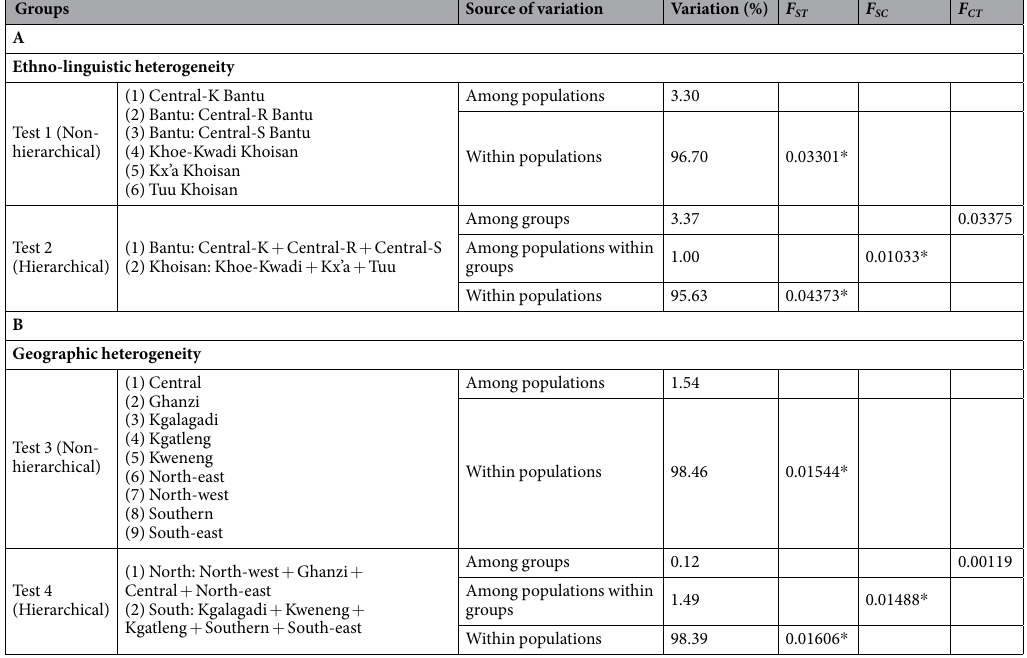
Non-hierarchical AMOVA testing for ethno-linguistic and geographical variation showed greater variation amongst self-declared ethno-linguistic groups than among the geographic groups at 3.30% and 1.54% respectively (Table 1 Test 1 and 3). Hierarchical AMOVA testing for ethno-linguistic variation between the self-declared Bantu and Khoisan ethno-linguistic population groups (n = 970) showed greater within population variation (95.63%) than among populations within groups (1.00%) (Table 1 Test 2). Hierarchical AMOVA testing for geographical variation between the northern and southern districts (n = 990) showed 0.12% variation amongst groups; and higher variation within populations at 98.39% than amongst populations within groups at 1.49% (Table 1 Test 4). Variation among populations within groups was higher when testing for geographic heterogeneity (1.49%) than for ethno-linguistic heterogeneity (1.00%). The relationship between Bantu and Khoisan self-declared sub-language ethno-linguistic groups is further illustrated using factorial correspondence analysis (FCA) (Fig. 2a) Bantu Central-S is an outlier. The Bantu Central-K and-R cluster together separated from the Khoisan sub-groups. This is a result of their common ori- gin (southwest Zambia) and subsequent gene flow as they settled in the same geographical region (Northwest district) 10 The FCA comparing the nine administrative districts illustrated in Fig. 2b shows the Ghanzi district is an outlier. The Northwest, Ghanzi, and Kgalagadi districts are slightly separated from the cluster formed by the remaining six administrative districts. This result illustrates both the close relationship of the Bantu Central-K and -R as well as the districts with Khoisan can be seen as outliers. F ST , AMOVA, and FCA show evidence of the greater influence of ethno-linguistics on population structure than geography. The partition of genetic variation within Botswana is due to ethno-linguistics which conse- quently influences the geographic distribution of genetic variation due to the geographic pattern of genetic distri- bution as evidenced by F ST , AMOVA and FCA data. The results of the model-based cluster analysis method in STRUCTURE are shown in Fig. 3, assuming K = 1–6 ancestral components. The Δ K method 52 identified three populations as having the highest level of genetic struc- turing. Three genetic clusters were also identified by InP(D | K) as the most likely K using the Evanno method 53 . TESS results indicate that there are two district genetic clusters in the Botswana population as seen in the plateau seen in the deviance information criterion (DIC) plot from the no-admixture model implemented in TESS. The ethno-linguistic population groups Bantu and Khoisan are distinguishable at K = 2 up until K = 6. Clustering analysis indicates that the largest concentration of the Khoisan ethno-linguistic group is in the Ghanzi district (Fig. 3). This is in accordance with the geographical data of this study (see Supplementary Table S7). Figure 3 also show two distinct Khoisan clusters in the Northwest district that correspond to two sampling sites on the Okavango Delta (Gudigwa and Xaixai) that are dense in Khoe-Kwadi and Kx’a people respectively. Using TESS results, we were able to show a geographical representation of the admixture coefficients through spatial krig- ing (Fig. 4). The Bantu and Khoisan ethno-linguistic population groups form distinct clusters with regions of admixture. STRUCTURE and TESS analysis did not detect substructure within the Bantu ethno-linguistic population groups. However, FCA indicates substructure within the Botswana Bantu ethno-linguistic groups. Even though central and southern African Bantu speaking groups have been found to be genetically similar, the exact patterns